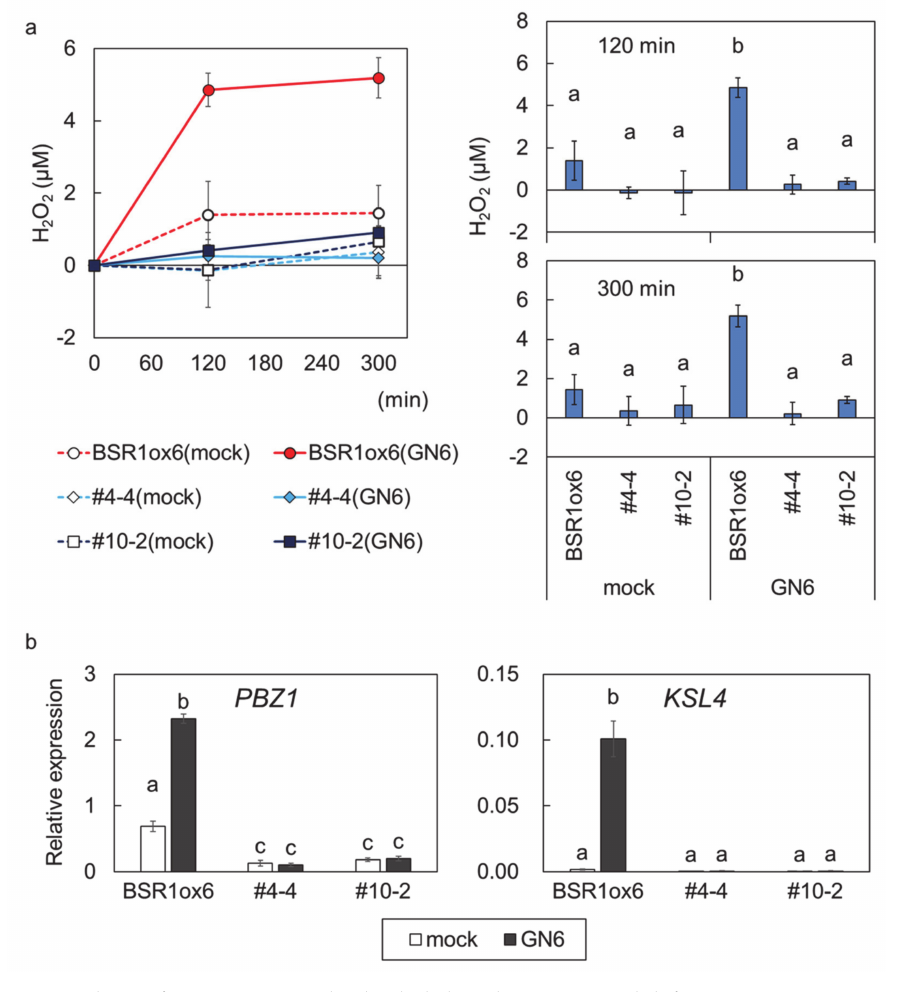
Figure 2. Knockout of OsCERK1 completely abolishes chitin-triggered defense responses in BSR1 - overexpressing leaf strips. ( a ) Chitin-triggered H 2 O 2 production. H 2 O 2 concentrations were measured by luminol-dependent chemiluminescence assay before treatment and at 120 min and 300 min after treatment. Left panel, time course of H 2 O 2 concentration; right panel, data, with di ff erent letters indicating significant di ff erences. ( b ) Transcript levels of defense-related genes in chitin-treated leaf strips. PBZ1 and KSL4 transcript levels at 5 h posttreatment were assessed by RT-qPCR. Values are presented as the means ± standard deviations of three biological replicates. Experiments were conducted twice, with similar results. Di ff erent letters indicate significant di ff erences (Tukey’s test; p < 0.05). Mock, treatment with water; GN6, treatment with 100 nM chitin hexamer ( N